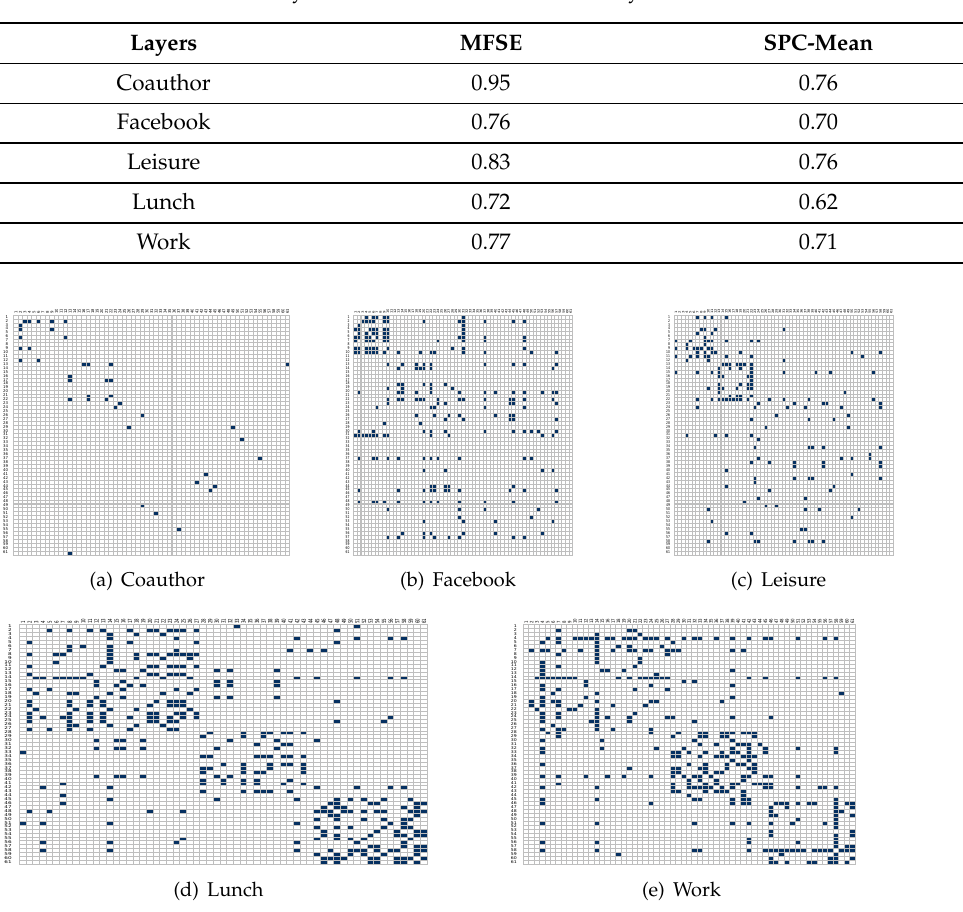
Figure 4. ( a – e ) Adjacency matrices of five layers on AU-CS network with nodes arranged according the community labels obtained by